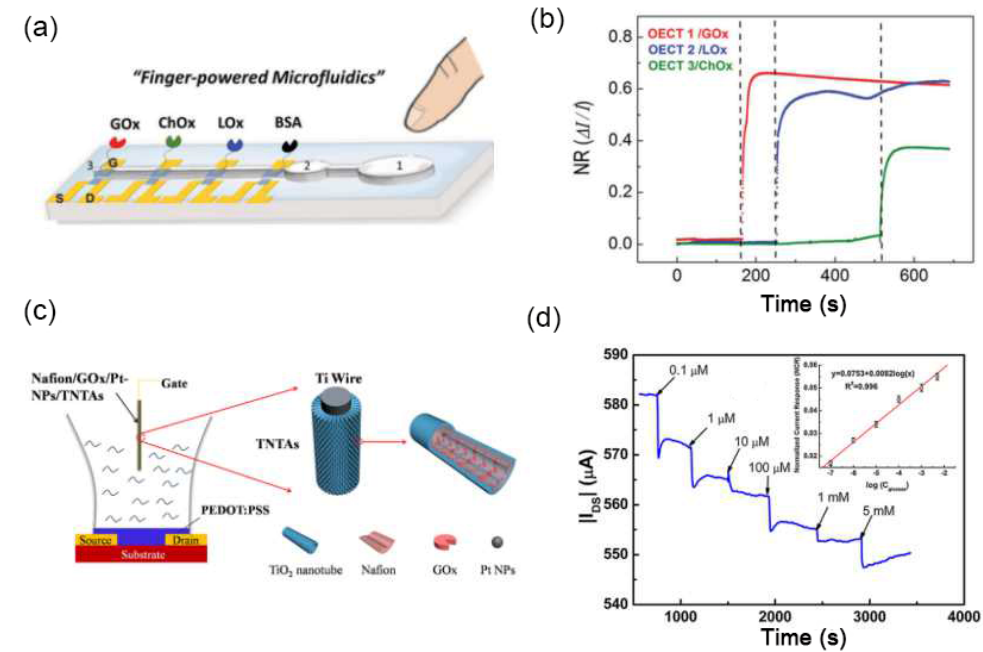
Figure 6. ( a ) Schematic diagram of a finger-powered PDMS microfluidic OECT platform and ( b )